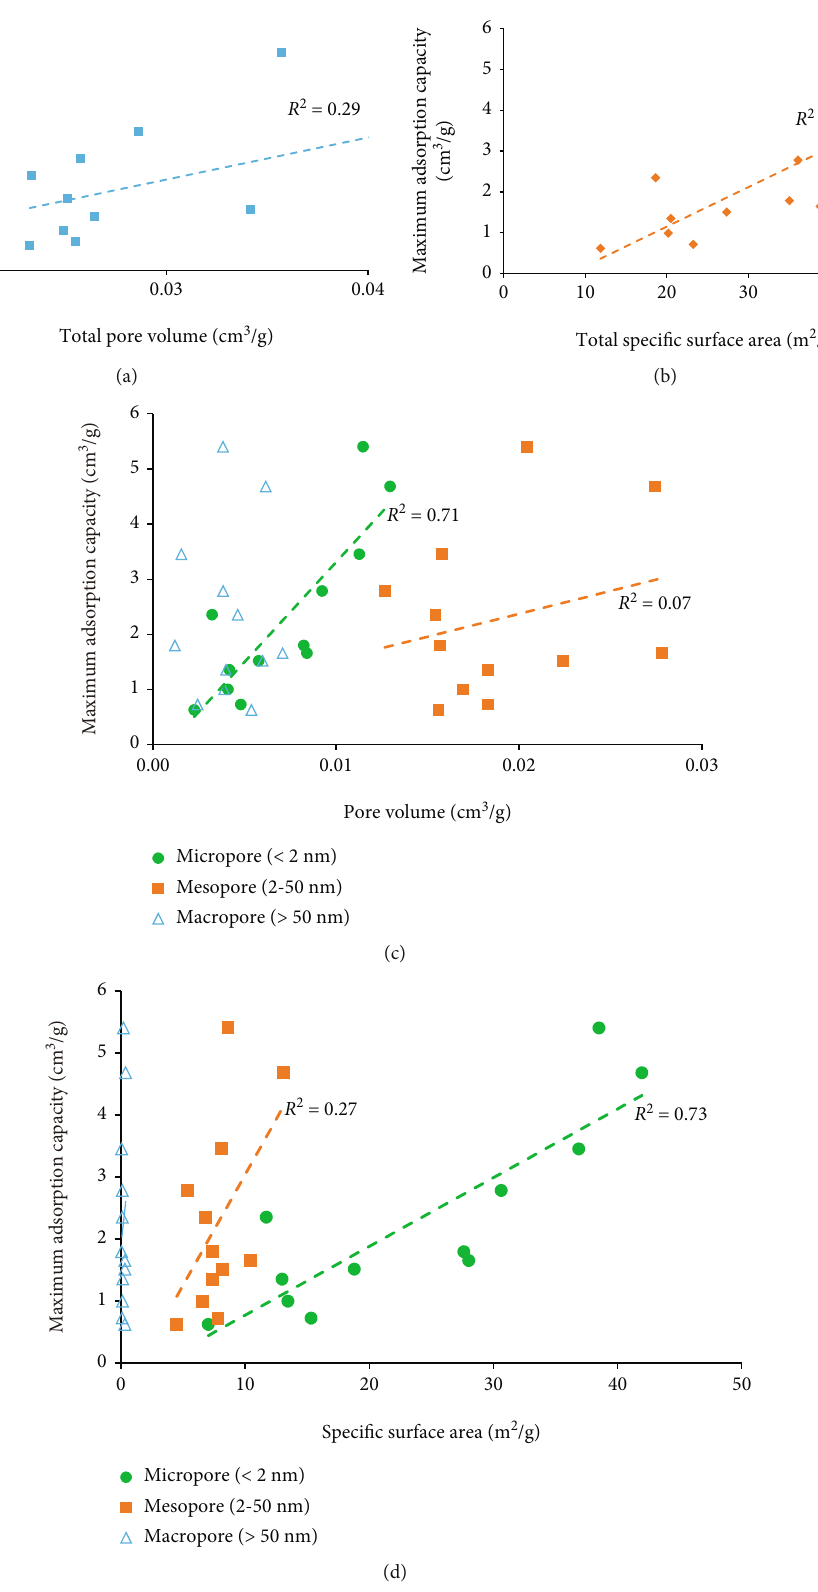
Figure 12: Cross-plots of maximum adsorption capacity with (a) total PV, (b) total SSA, (c) PV, and (d)